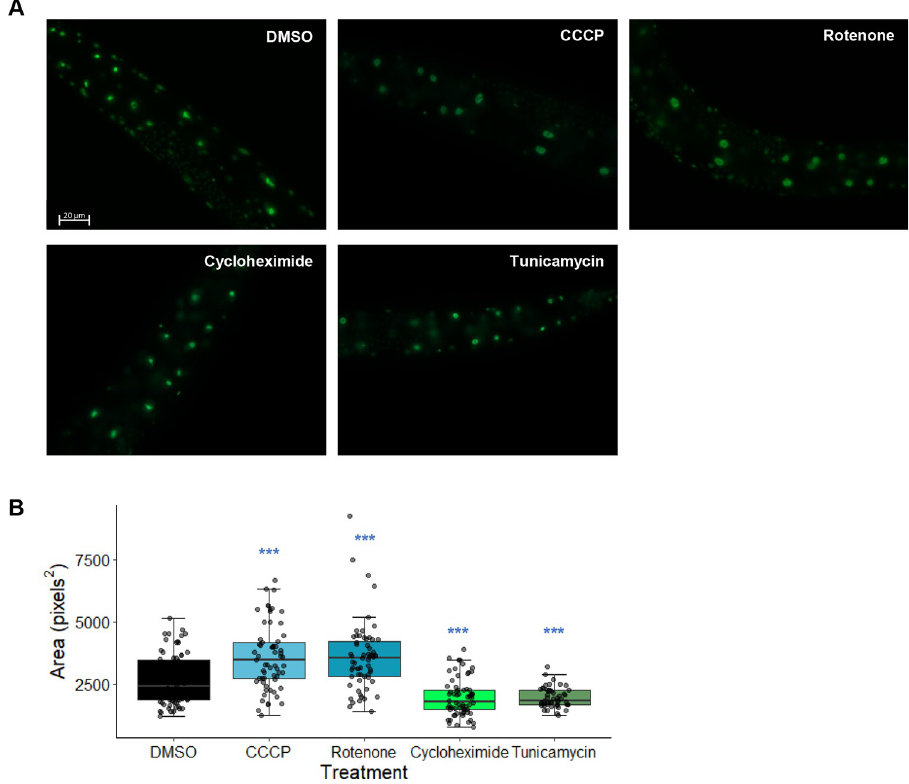
Fig 4. Mitochondrial disruption increases the size of Pfib-1 ::FIB-1::eGFP fluorescent punctae. (A) Images and (B) quantification of FIB-1::eGFP in worms treated for 4 hours with vehicle (DMSO), 10 μ M CCCP, 50 μ M rotenone, 2 mg/mL cycloheximide, or 60 μ M tunicamycin. Three biological replicates with ~25 worms/replicate were analyzed. p- values were determined from one-way ANOVA, followed by Dunnett’s test. ��� p < 0.001. ruvb-1/RUVB(RNAi) in a worm strain carrying an endogenously expressed, GFP-tagged FIB-1 ( Pfib-1 ::FIB-1::eGFP) was tested to determine the expression and localization of FIB-1/ FBL. Knockdown of fib-1/FBL starting at L1 or L3 significantly reduced FIB-1 fluorescence